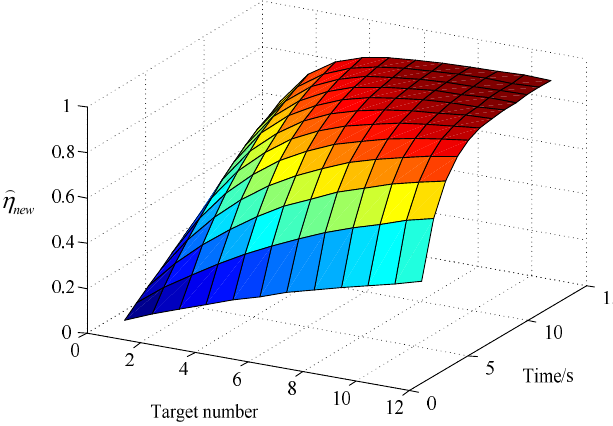
 (cid:95)   η for different target for different target numbers. Figure 4. Change curves of IPF  new new for different target numbers. new